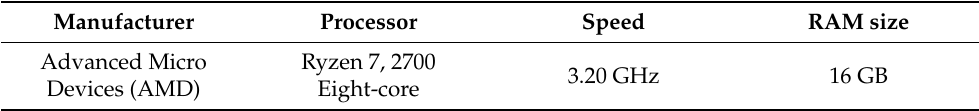
Table 2. Specification of computational hardware